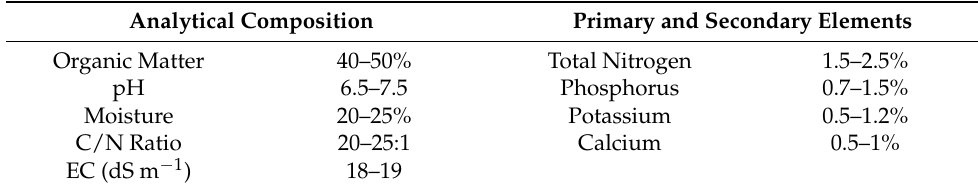
Table 5. Chemical properties of bovine